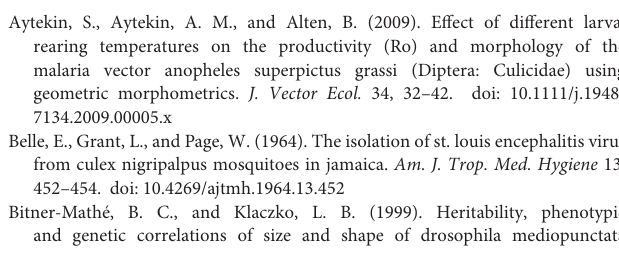
Supplementary Table 1 | Data dictionary of the semantic restrictions applied to